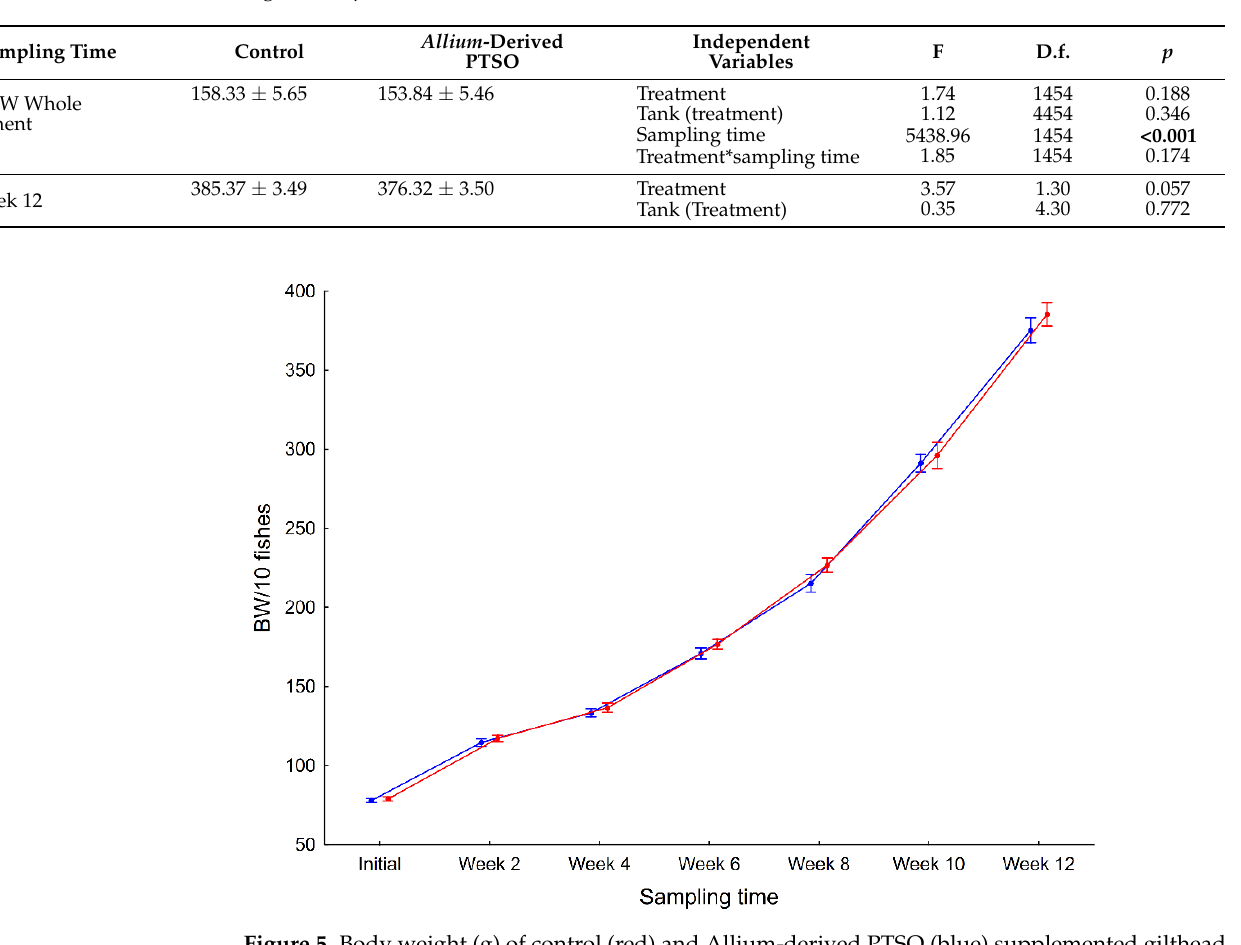
Table 3. General linear mixed models exploring the effects of treatment as a factor, sampling time as a continuous factor, and tank nested in treatment as a random factor in the body weight (BW) of gilthead seabream juveniles fed with control diet or supplemented with Allium -derived PTSO (average ± SD). D.f. refers to degree of freedom. Sample unit is the body weight of 10 fish. The first number is the degree of freedom of the independent variable, and the second is for the error term. Significant p -values are shown in bold.